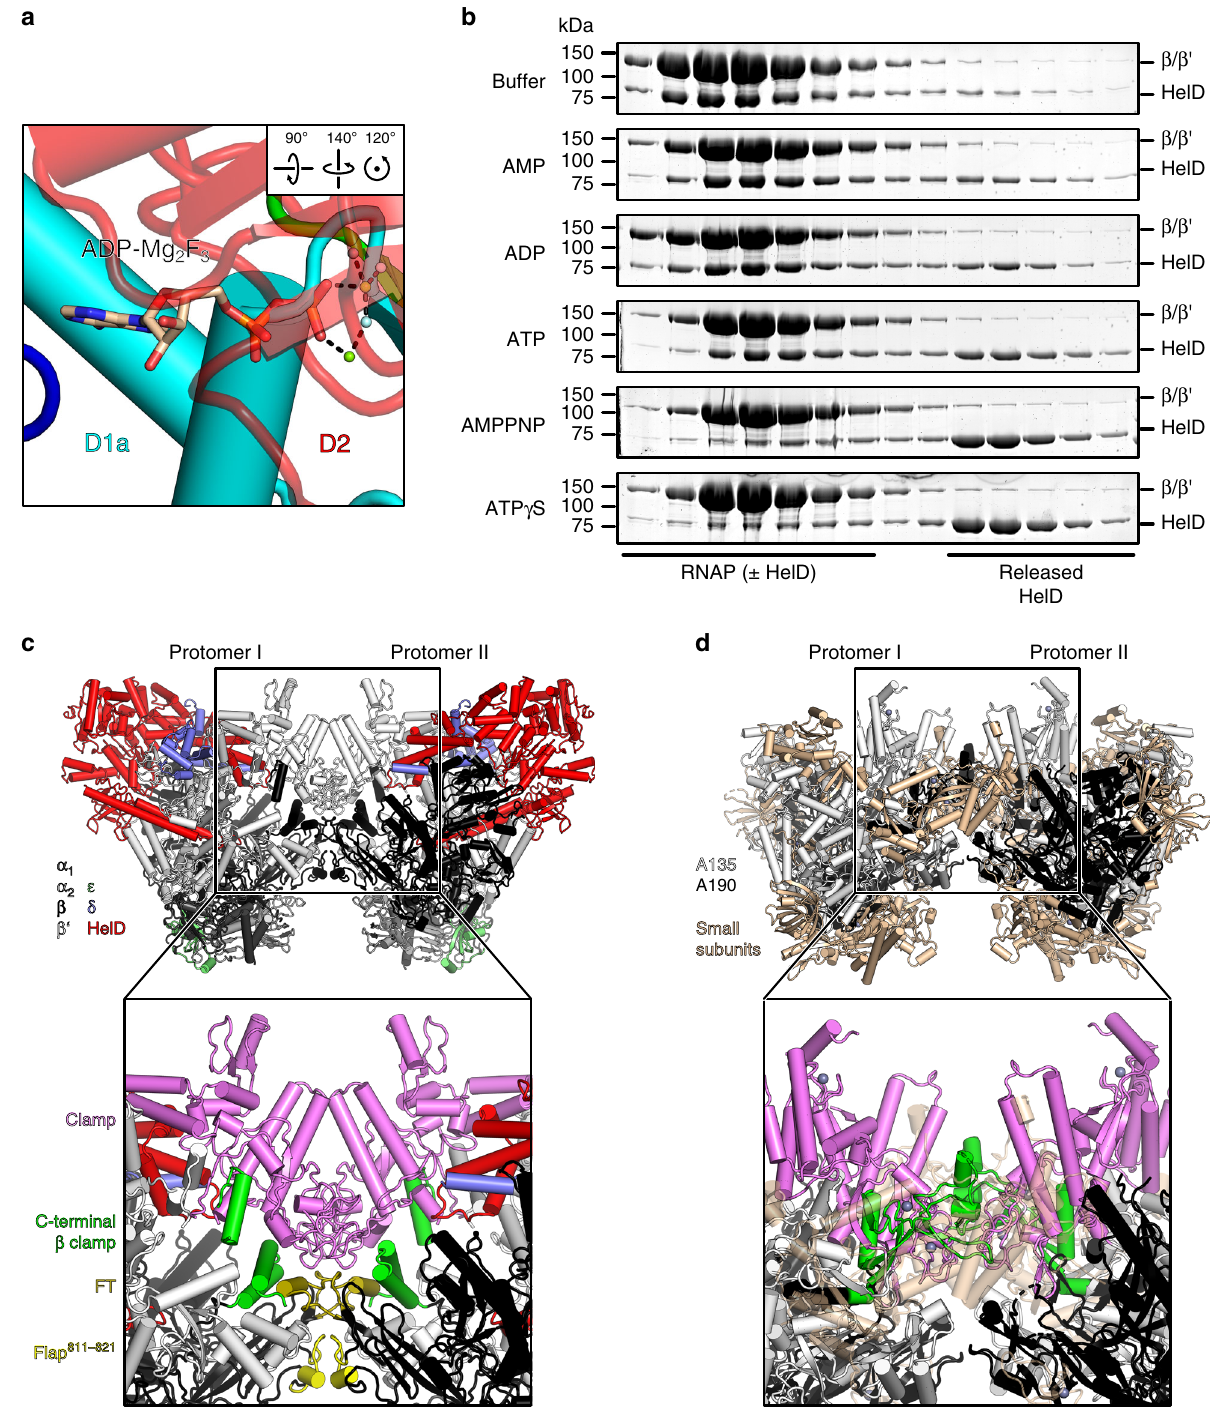
Fig. 6 HelD release and RNAP-HelD complex dimerization. a Close-up view of the ATP-binding site of HelD, with ADP-Mg 2 F 3 from a UvrD complex (PDB ID 2IS6) transferred by superpositioning of the UvrD NTPase domains on HelD, illustrating clashes with the nucleotide. ADP-Mg 2 F 3 shown as sticks and colored by atom type; carbon, beige; nitrogen, blue, oxygen, red, phosphorus, orange; magnesium ions, green; fl uoride ions, light blue. b SDS-PAGE analysis of SEC runs after treating RNAP- δ -HelD with buffer or the nucleotides indicated on the left. Experiments were repeated independently at least twice with similar results. For full gels, see Supplementary Fig. 7b. c Structure of dimeric RNAP- δ -HelD. Inset, close-up view on the dimer interface. The two protomers interact via the elements highlighted in colors; β ′ clamp, violet; C-terminal β clamp, green; β fl ap tip (FT), olive; residue 811 – 821 of the β fl ap (Flap 811 – 821 ), yellow. d Structure of a hibernating RNAP I dimer (PDB ID 4C2M). A135 subunit, black; A190 subunit, white; small subunits, beige. Inset, close-up view on the dimer interface. A190 clamp, violet; C-terminal A135 clamp,